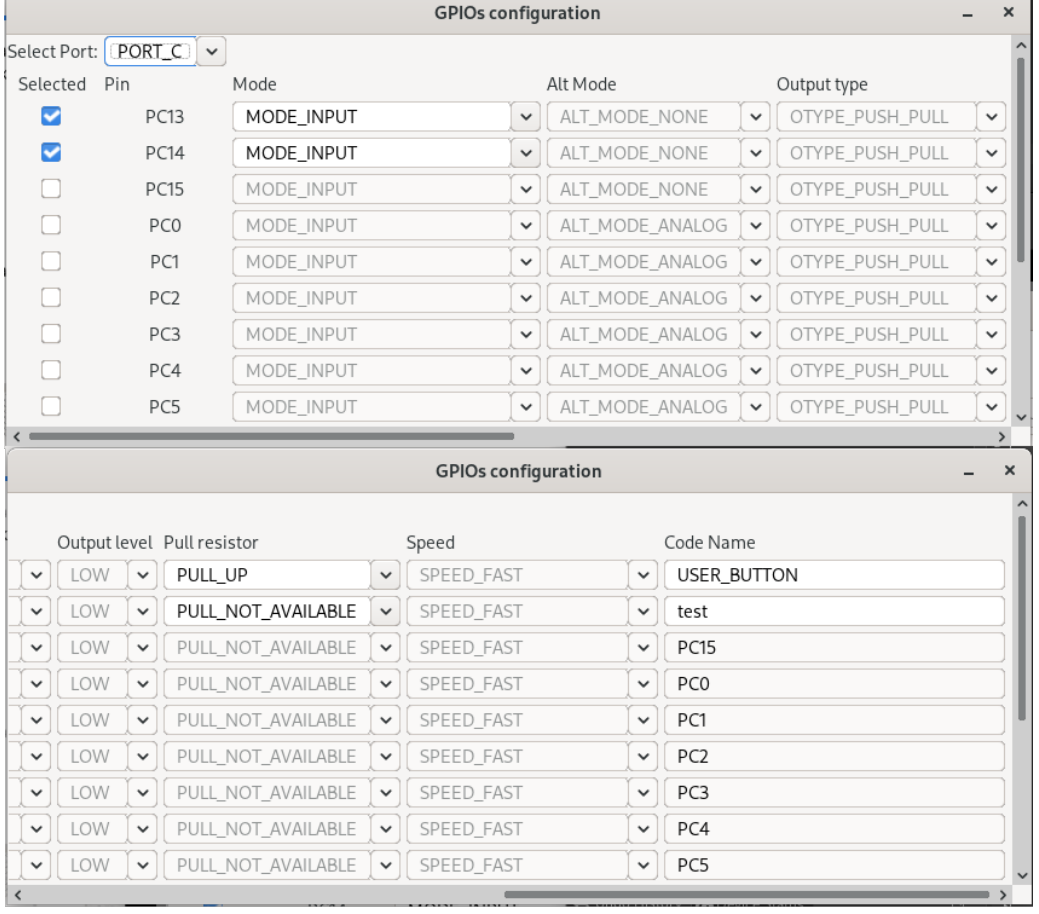
Figure 8. General Purpose Input/Outputs configuration screen.